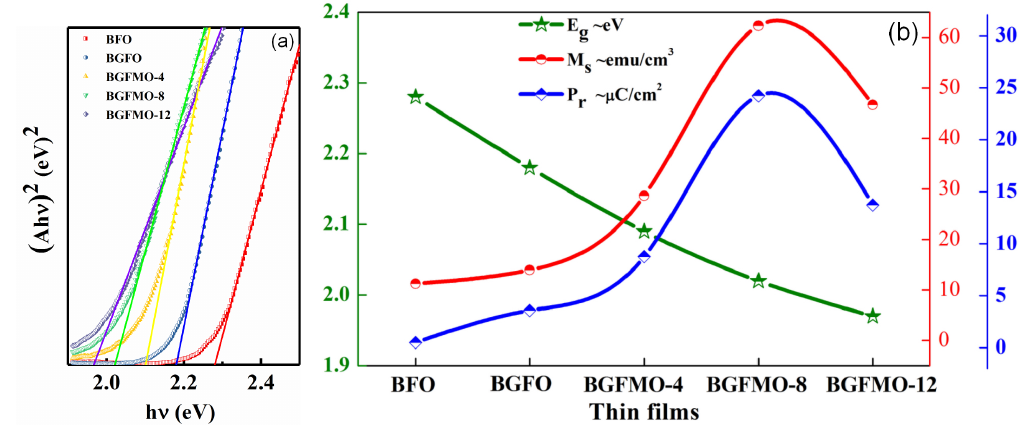
Figure 5. ( a ) Band gap of different film samples. ( b ) The relationship curves between Pr, Ms and E g